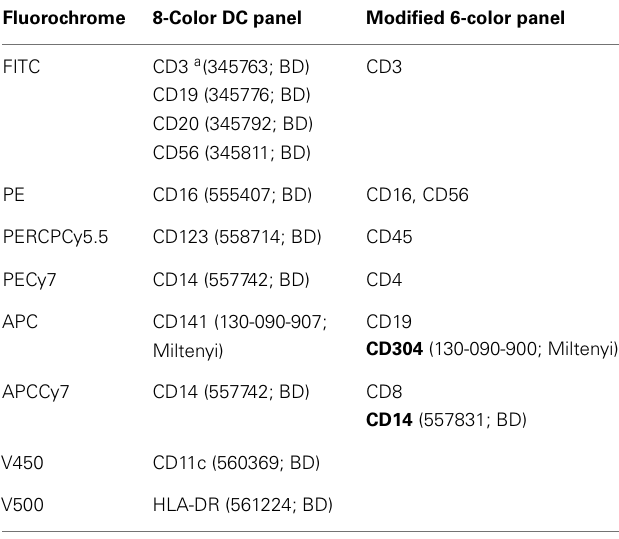
Table 1 |Antibody panels used for flow cytometry analysis